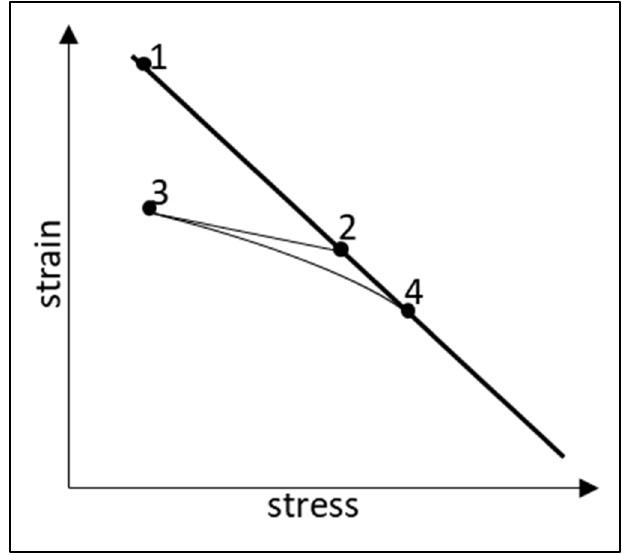
Figure 15. Stress loading – unloading – reloading path.